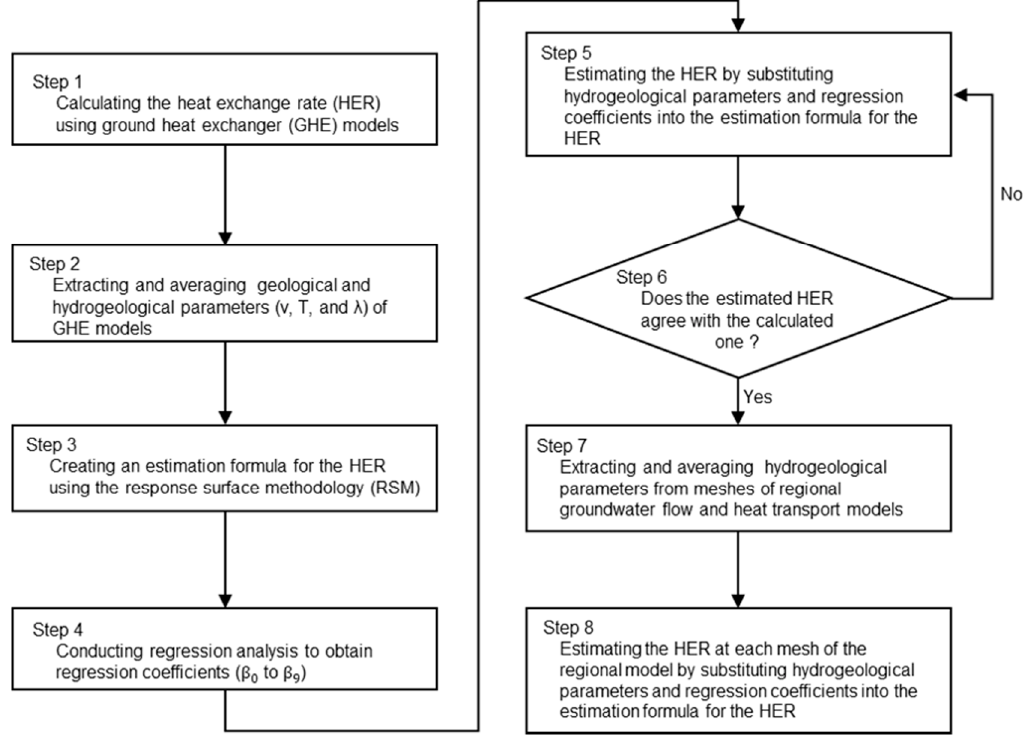
Figure 4. Flowchart of the proposed method in this paper.